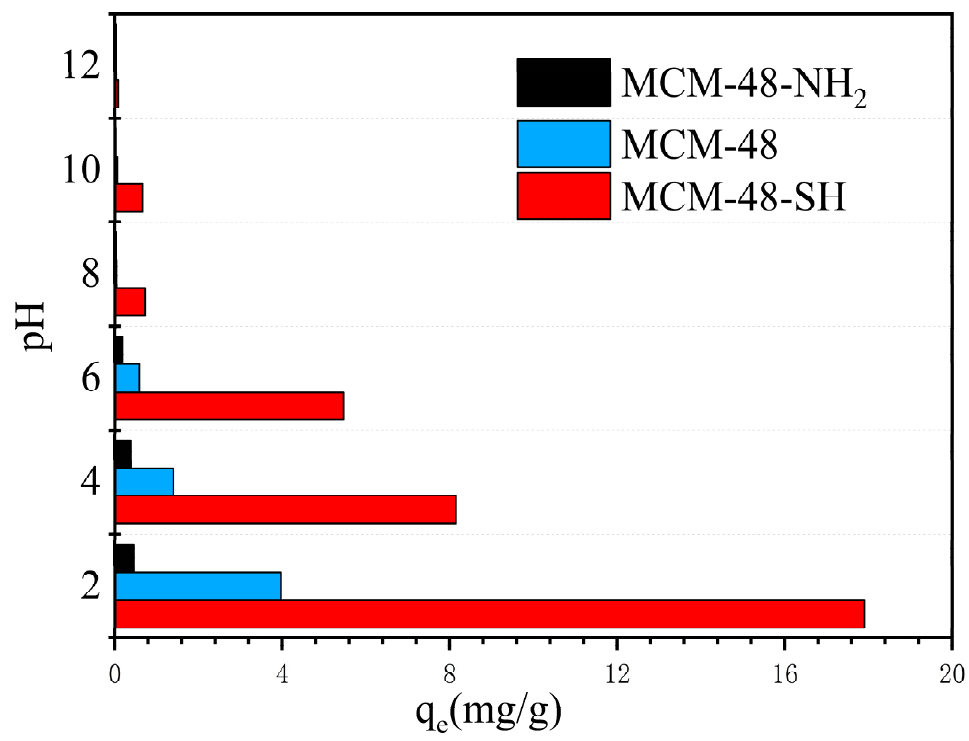
Figure 9. Adsorption effect diagram of MCM-48-SH, MCM-48, and MCM-48-NH 2 at different pHs (the reaction temperature was 25 °C, the amount of adsorbent was 25 mg, and the reaction time was 3 d).